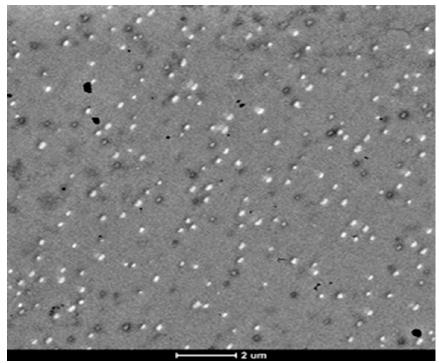
Figure 9. TEM image of PU-15.